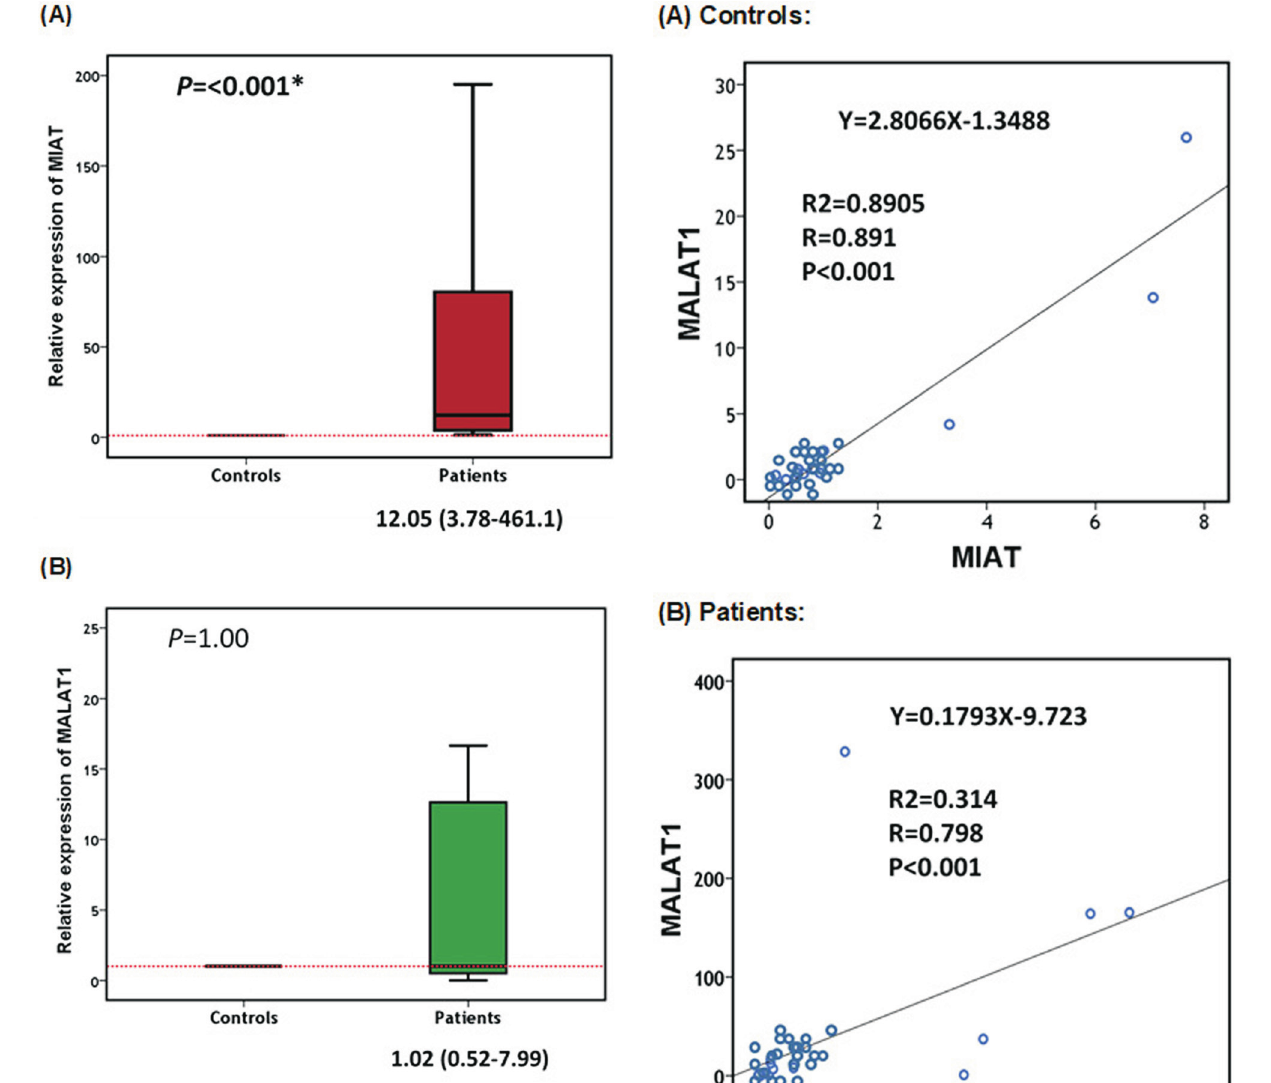
Figure 1 - Peripheral blood expression levels of MIAT (A) and MALAT1 (B) in patients and controls. Data are represented as medians. The box de- fines upper and lower quartiles (25% and 75%, respectively), and the error barsindicateupperandloweradjacentlimits.Relativeexpressionlevelsof MIAT and MALAT1 were normalized to GAPDH expression level for each sample and calculated using the delta-delta Cq method [=2 (- (cid:5)(cid:5) Cq) ] in com - parison to controls. Mann-Whitney U test was used for comparison.